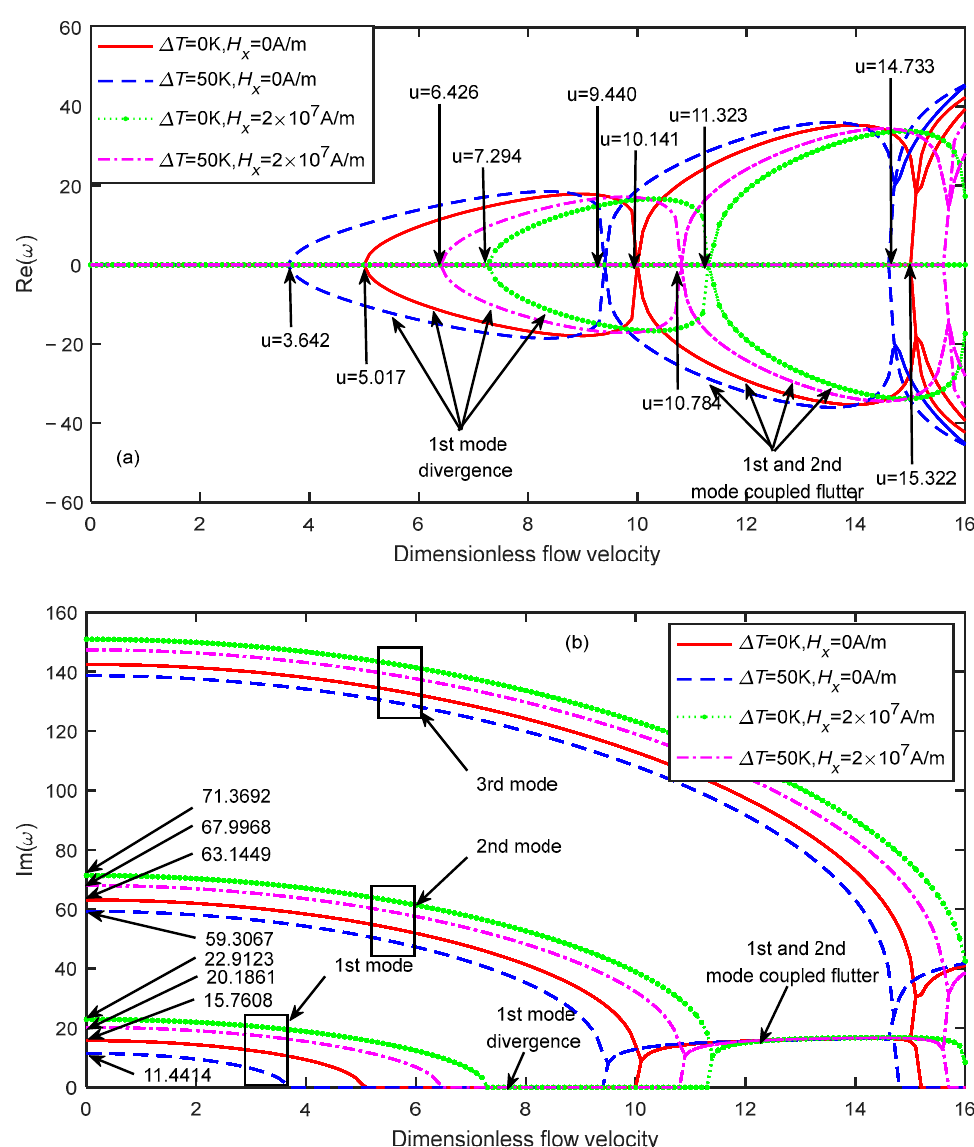
Figure 8. Dimensionless eigenfrequency variations with dimensionless flow velocity under different thermo-magnetic coupled fields ( δ = 3). ( a ) Real part. ( b ) Imaginary part.